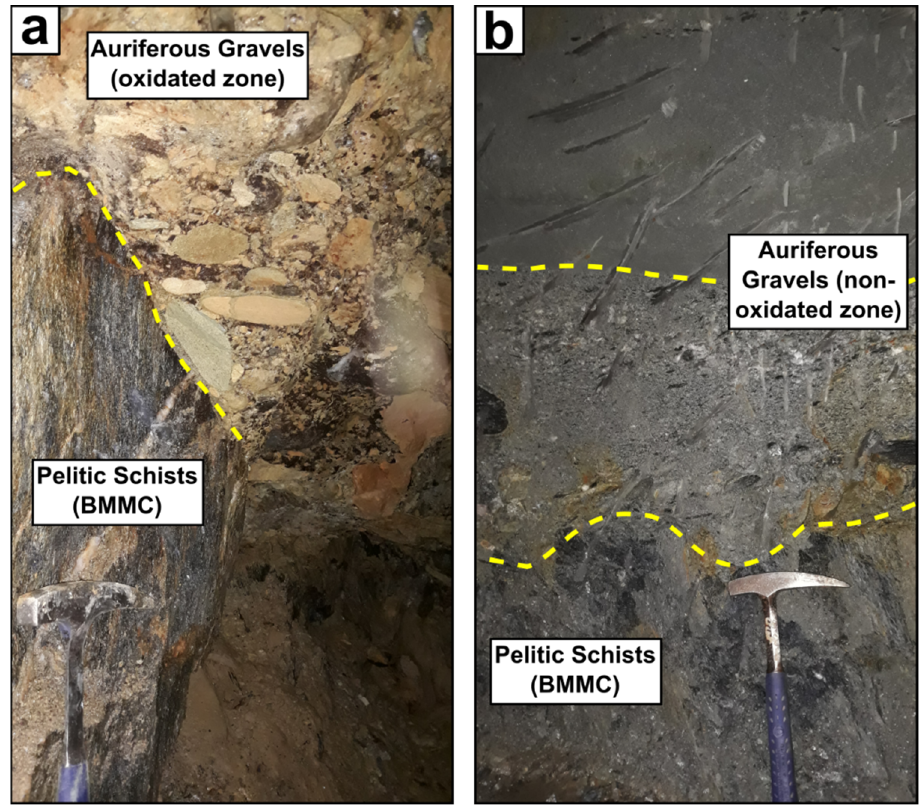
Figure 2. Auriferous gravels overlying pelitic schists of BMMC. Photographs from underground workings, following the boundary between gravels and bedrock (pelitic schists) within the terraced deposits. ( a ) A near-surface oxidated zone of gravels that exhibit reddish colors. ( b ) Farther surface non-oxidated zone of gravels, exhibiting bluish grey colors. In both locations, sediments for hand- panning were taken immediately above the contact with pelitic schists (above the yellow dashed line).